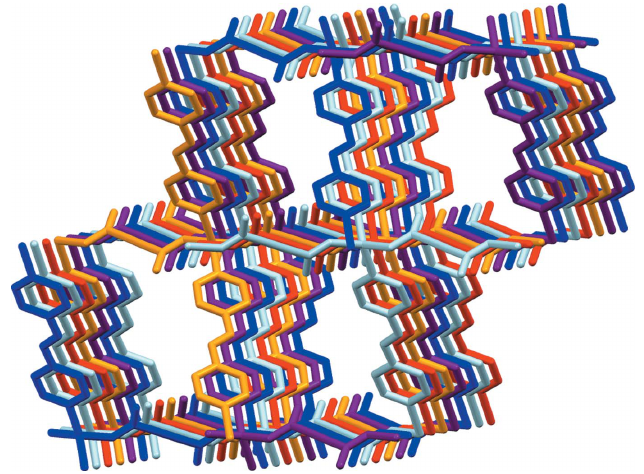
Figure 3 Fivefold interpenetrated three-dimensional networks of the title compound are shown in different colors. Water solvate molecules and all hydrogen atoms are omitted for clarity.